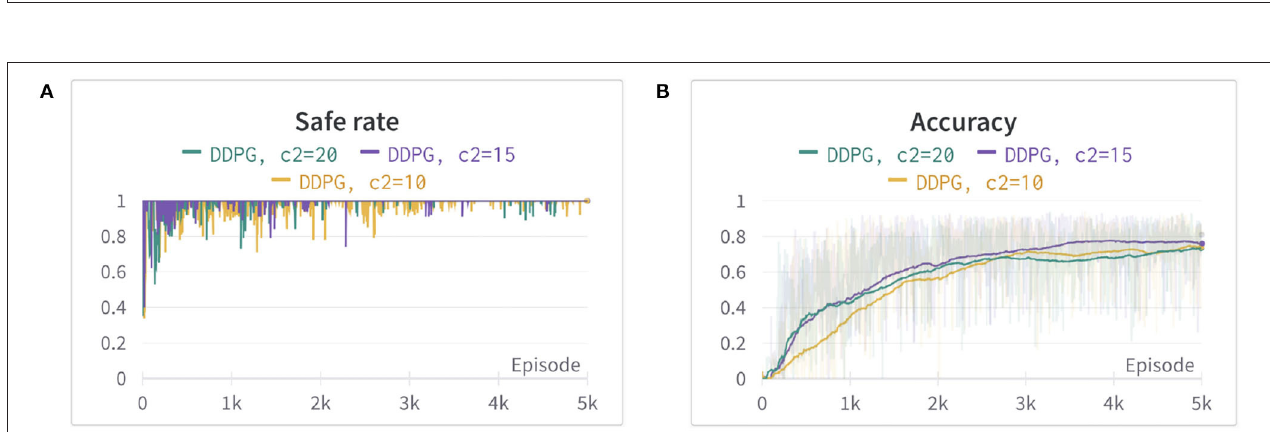
FIGURE 2 | The comparison between different power ( n ) of the exponential decay function. (A) The safe rate (defined in Section 4.2) of three different power ( n ) of the exponential decay function. (B) The accuracy (defined in Section 4.2) of three different power ( n ) of the exponential decay using an exponential moving average for better visualization. The two figures show that n = 35 has better learning efficiency, safe rate, and accuracy.